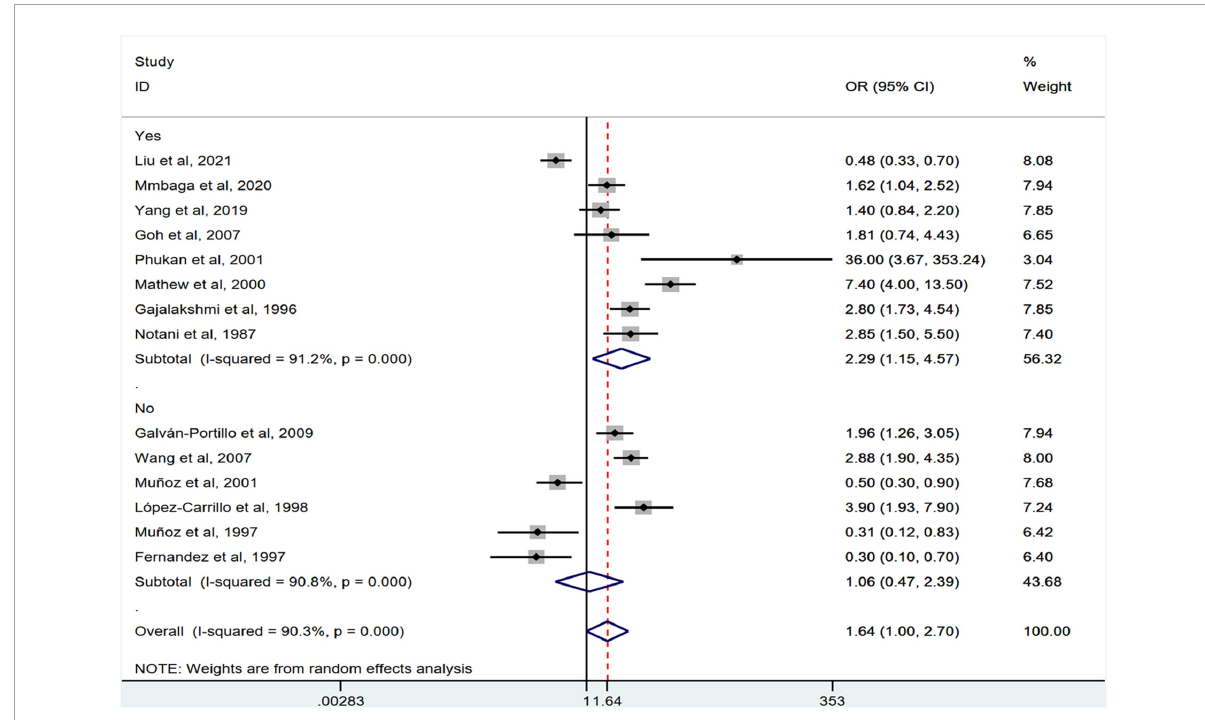
FIGURE8 Subgroup analysis showing associations between chili pepper consumption and the risk of GI cancers based on the adjustment for alcohol intake.